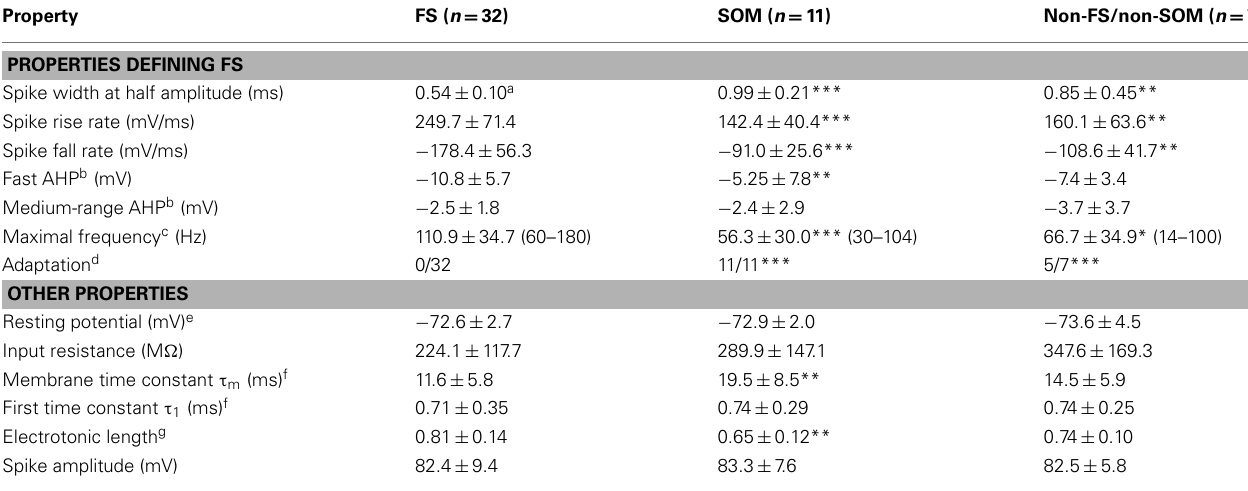
Table 2 | Electrical properties of each subgroup of GABAergic interneurons.